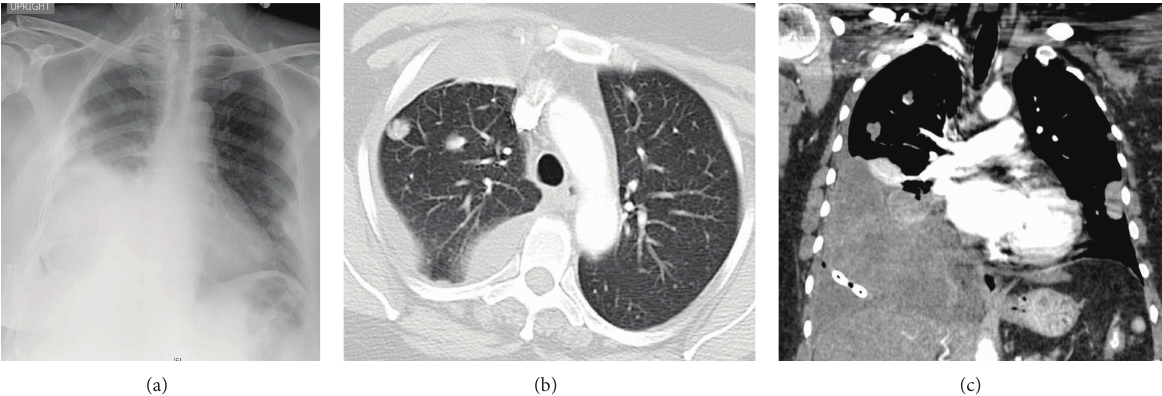
Figure 3: (a) CXR showing residual lower lobe collection of fluid after insertion of chest tube. (b) Transverse section of thorax by CT showing restoration of lung parenchyma in the upper lobe of the right lung. (c) Coronal section of thorax by CT showing a significant collection of fluid in the middle and lower right lobes of the